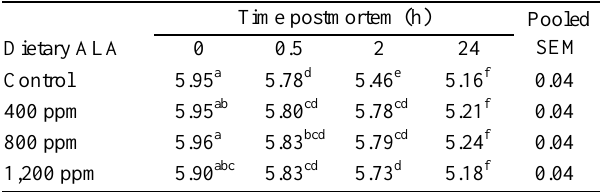
Table 4. Effects of dietary ALA on postmortem muscle pH